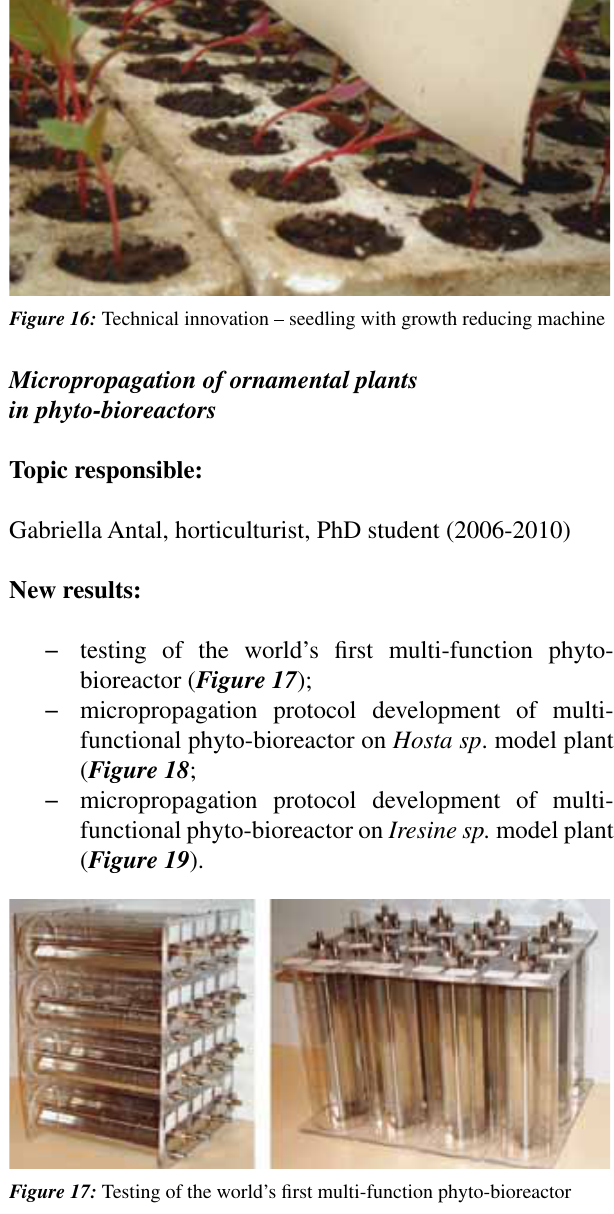
Figure 15: Selection and appearance of yellow crop-cover ornament oil tree (Ricinus communis)